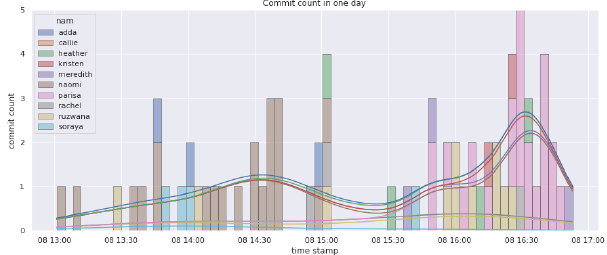
Figure 8 - Commit counts for game development.